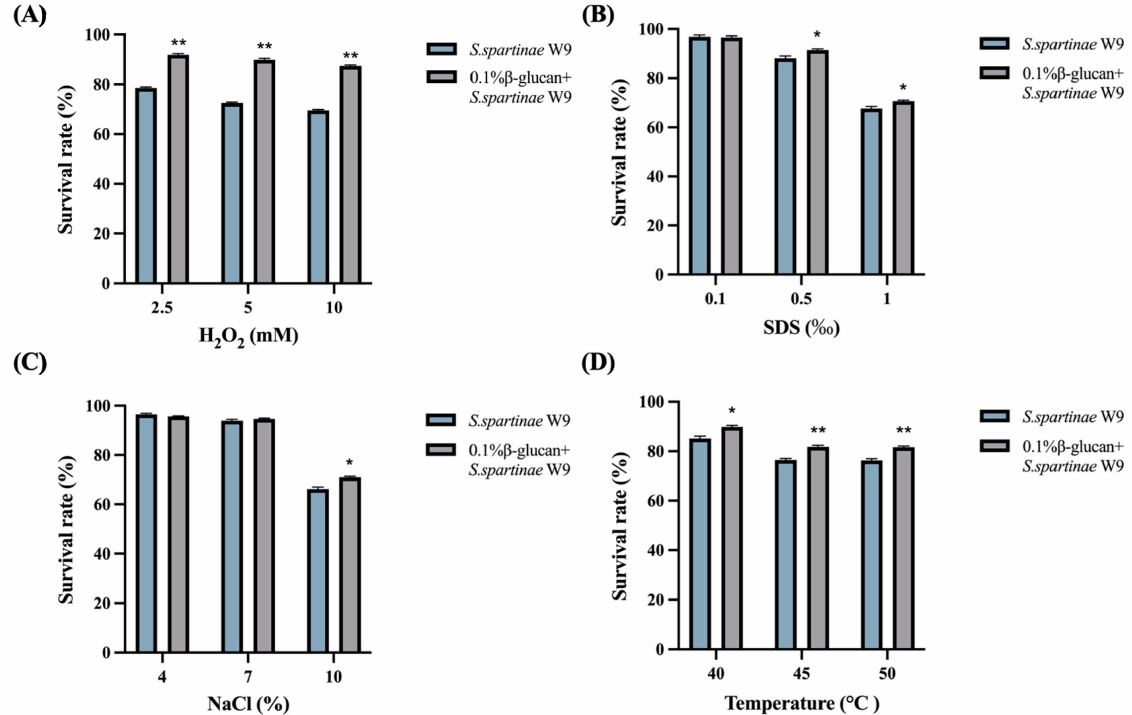
Figure 5. Effects of 0.1% β -glucan on the survival rate of S. spartinae W9 under different stresses. ( A ) The survival rate of S. spartinae W9 under oxidative stress caused by H 2 O 2 . ( B ) The survival rate of S. spartinae W9 under plasma membrane stress caused by SDS. ( C ) The survival rate of S. spartinae W9 under hyperosmotic stress caused by NaCl. ( D ) The survival rate of S. spartinae W9 under high temperature stressor. Asterisks indicate a significant difference between S. spartinae W9 cultured with or without 0.1% β -glucan identified by the t -test (*, p < 0.05; **, p <